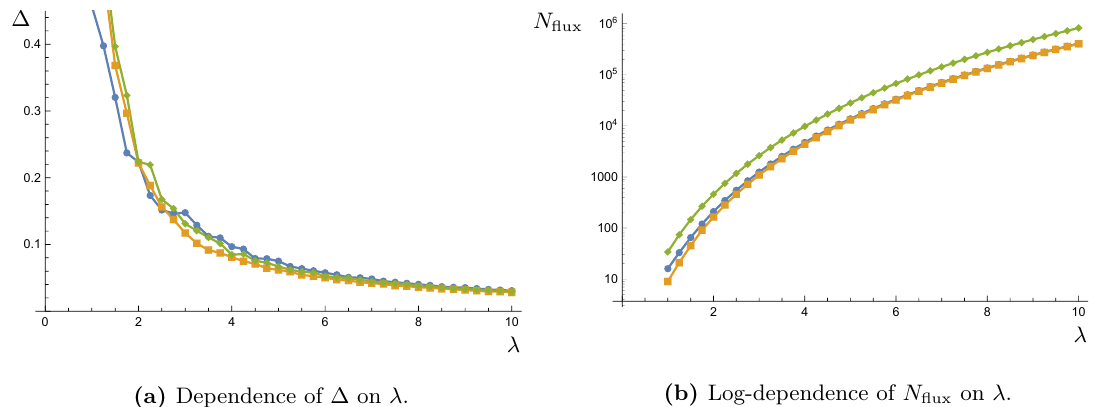
Figure 5. Conifold-large complex-structure limit: dependence of the relative difference ∆ and of the tadpole contribution N on the hierarchy parameter λ . The plots show three different families, flux which all show a similar